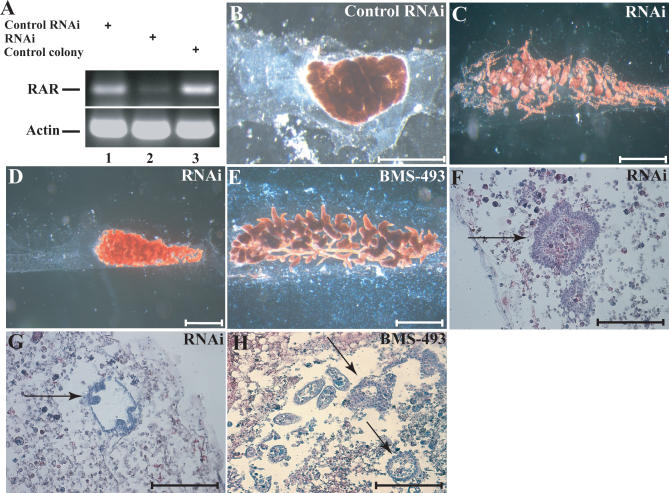
Disruption of RAR Function during Regeneration Causes Bud MalformationsIn order to verify the efficiency and ability of RAR siRNAs to interact and decrease RAR RNA levels, we added RAR siRNAs and control siRNAs to B. leachi colonies and compared RAR RNA levels to untreated colonies. Control siRNAs and untreated colonies exhibit approximately the same transcripts levels (A) (lanes 1 and 3), while RAR siRNAs show a significant reduction in RAR RNA levels (A) (lane 2). Actin transcript levels remain unchanged, indicating the viability of the tissue. After 6 d, control experiments using the control siRNAs completed vasculature movements, forming opaque vessel masses as specified before (B) (compare to Figure 1F). In contrast, in RNAi-affected experiments, blood vessels remained apart, situated haphazardly within the tunic matrix (C) (compare to Figure 5A). In several experiments, vessel movement halted in an intermediate state (D). A similar phenotypic morphology was observed with the RAR pan-antagonist BMS-493 (E). Histological sections reveal malformation of regenerating buds in RNAi treatments (F, arrow, compared to Figure 5E and 5F). In mild cases, buds reached progressive developmental stages but failed to invaginate properly (G, arrow). A similar histological phenotype is observed in BMS-493-treated fragments exhibiting malformed epithelial spheres (H, arrows). Scale bar in (B–E) represents 1 mm; scale bar in (F–H) represents 100 μm.